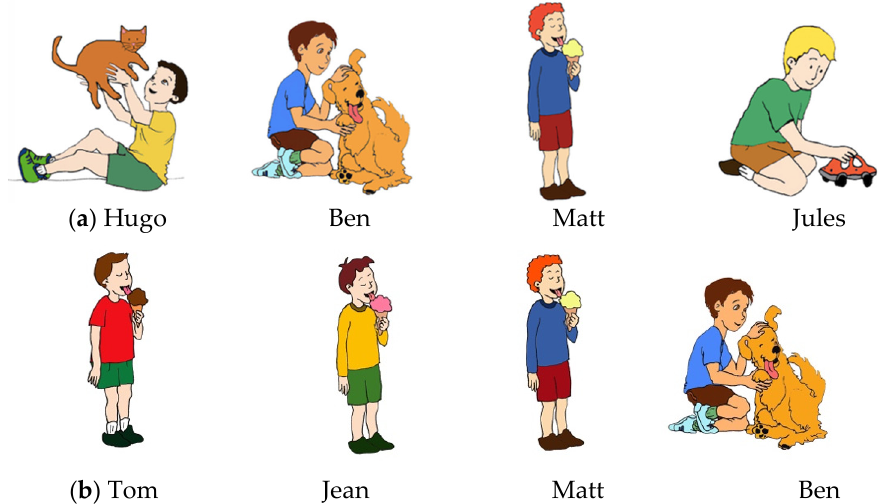
Figure 3. Pictorial stimuli: ( a ) exhaustive condition; ( b ) non-exhaustive condition.